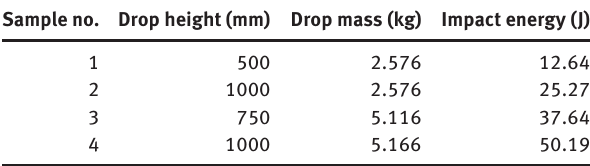
Table 1 Impact test parameters